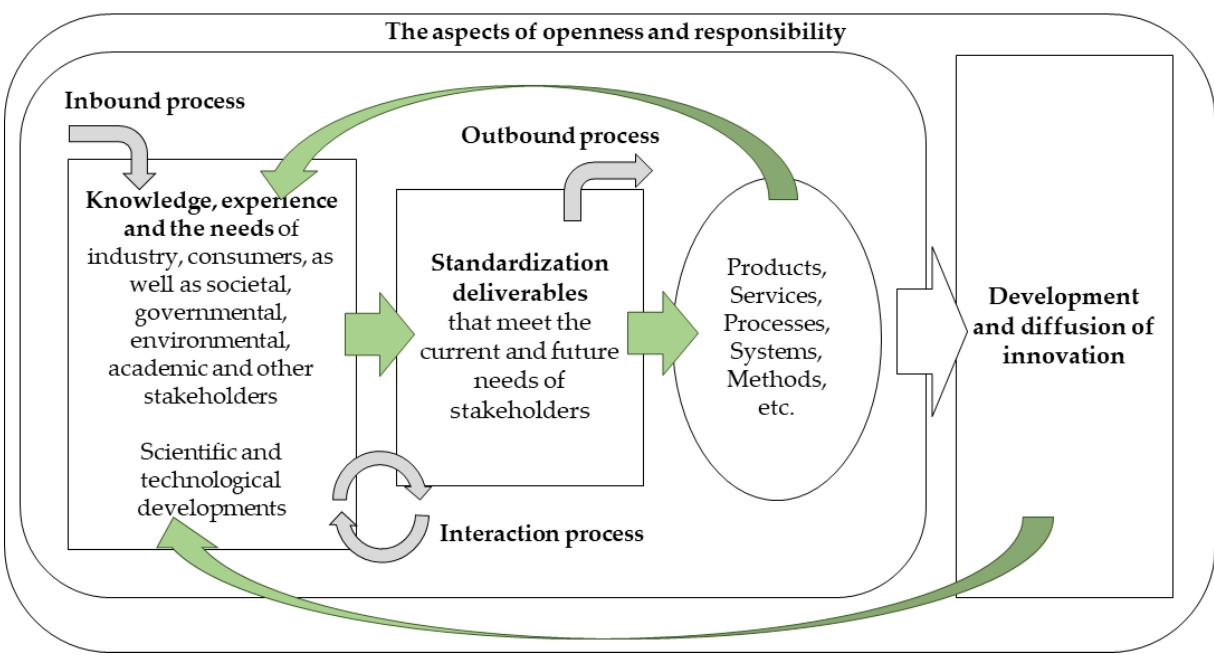
Figure 2. The interrelation between standardization and open and responsible innovation (created by the authors) .